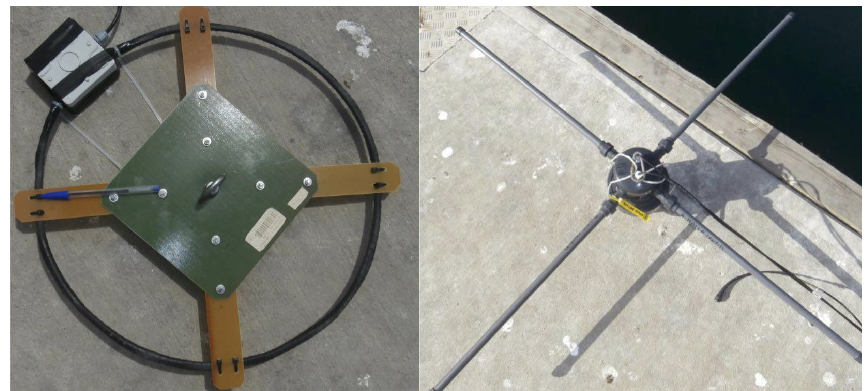
Figure 4. Antenna examples: on the left 22 cm magnetic loop and insulated crossed-dipole on the right